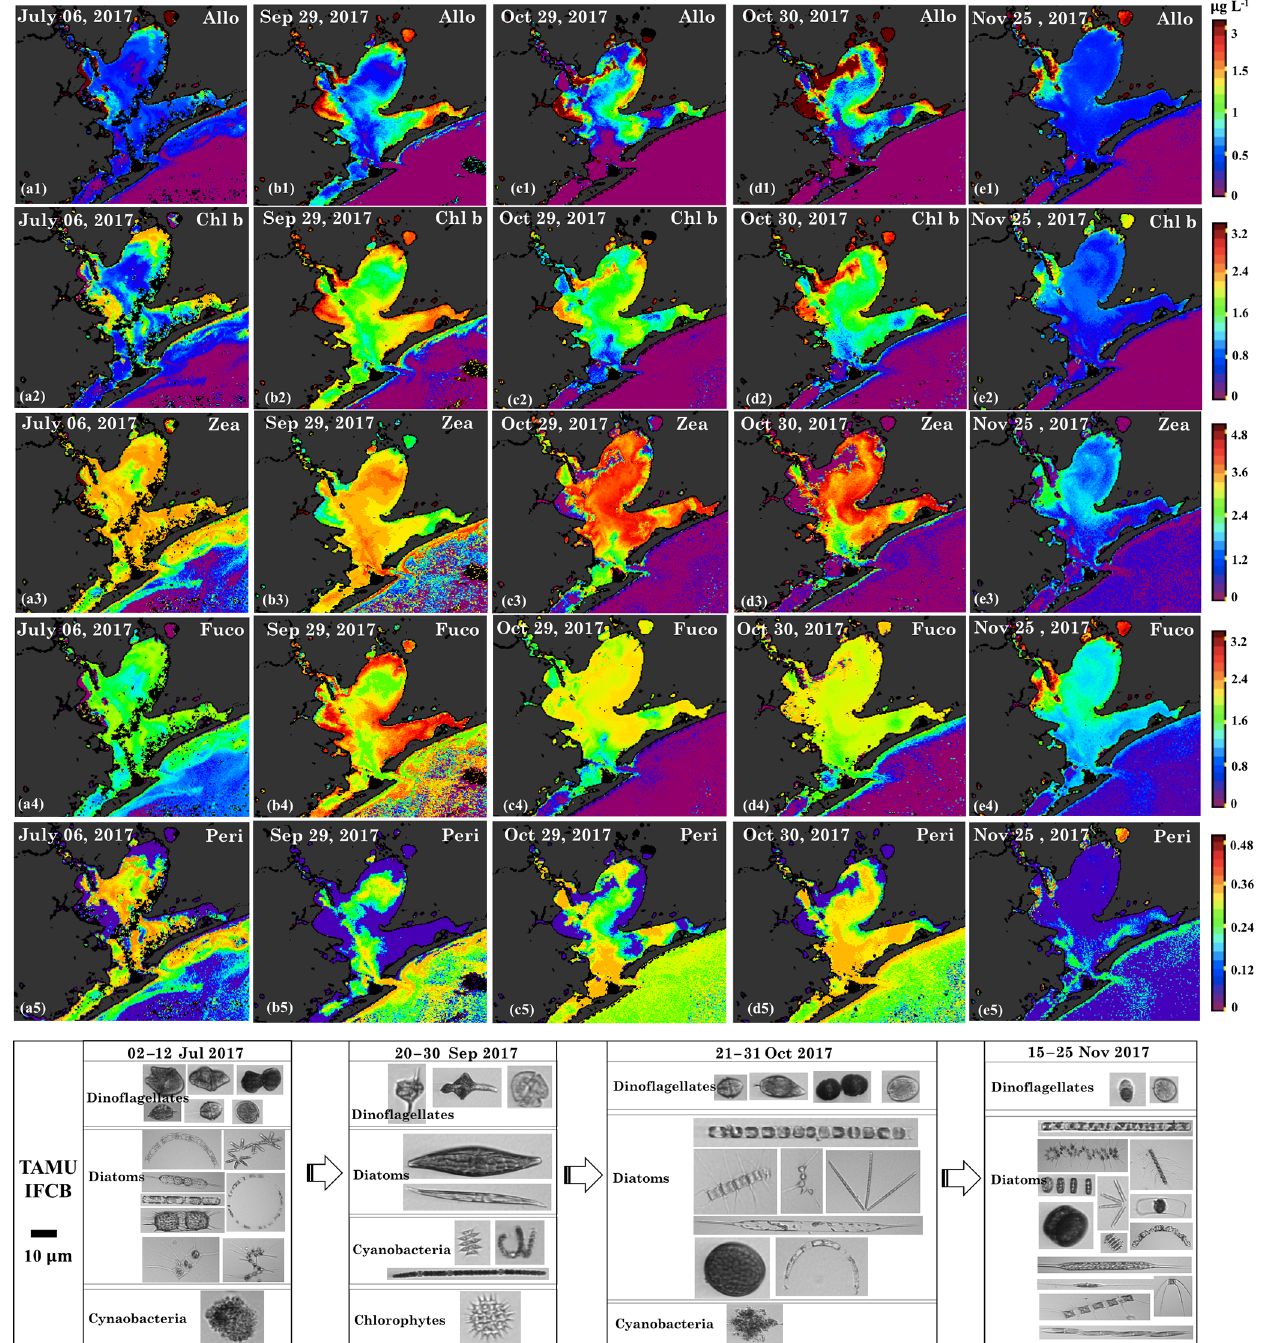
Figure 14. Sentinel-3A OLCI-derived maps of diagnostic pigment concentrations for Galveston Bay. Simulated (a1–e1) alloxanthin, (a2– e2) Chl b , (a3–e3) zeaxanthin, (a4–e4) fucoxanthin and (a5–e5) peridinin concentrations. Panels (a) , (b) , (c) , (d) and (e) represent columns (maps for 6 July, 29 September, 29–30 October and 25 November 2017), respectively and panels 1–5 represent rows (pigments). Panels (f) , (g) , (h) and (l) are the corresponding IFCB data for 6 July, 29 September, 29–30 October and 25 November 2017, respectively. Note that IFCB pictures of freshwater species including chlorophytes and cyanobacteria that appeared on 20–30 September 2017 have been zoomed in for better